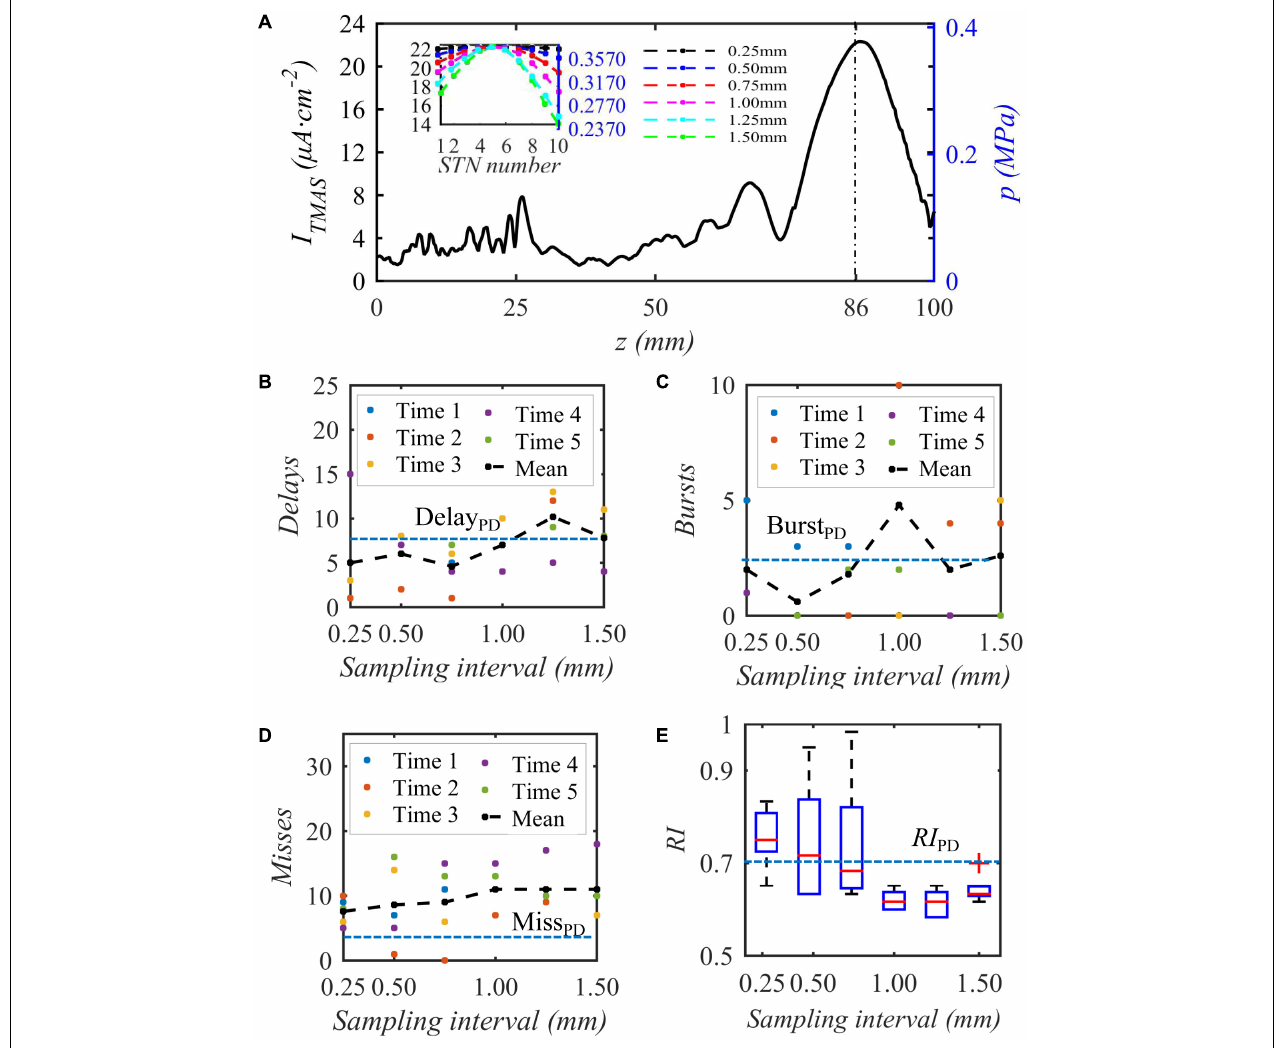
FIGURE 10 | The influence of the biased ultrasound distribution on the abnormal discharge of the Th nerve nucleus in the BG-Th neural network. (A) is the acoustic axis sound pressure and the TMAS-induced current density after sampling (block diagram), (B–D) Number of delay, burst and missed firing, (E) RI from Th, ( f = 0.5 MHz, f s = 10 Hz, T 1 /T s = 50%, I 0 = 0.2 W cm - 2 , B = 0.3